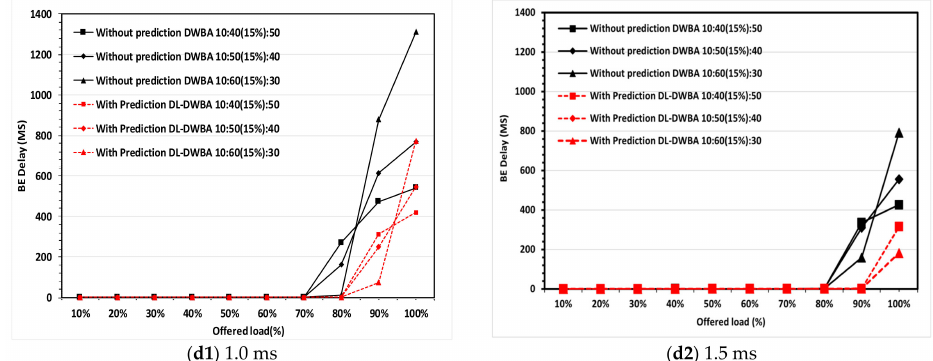
Figure 6. Mean packet delay comparison in different traffic scenarios in 1.0 and 1.5 ms cycle time. ( a ) EF ( a1 , a2 ), ( b ) TI ( b1 , b2 ), ( c ) AF ( c1 , c2 ), and ( d ) BE ( d1 , d2 ).